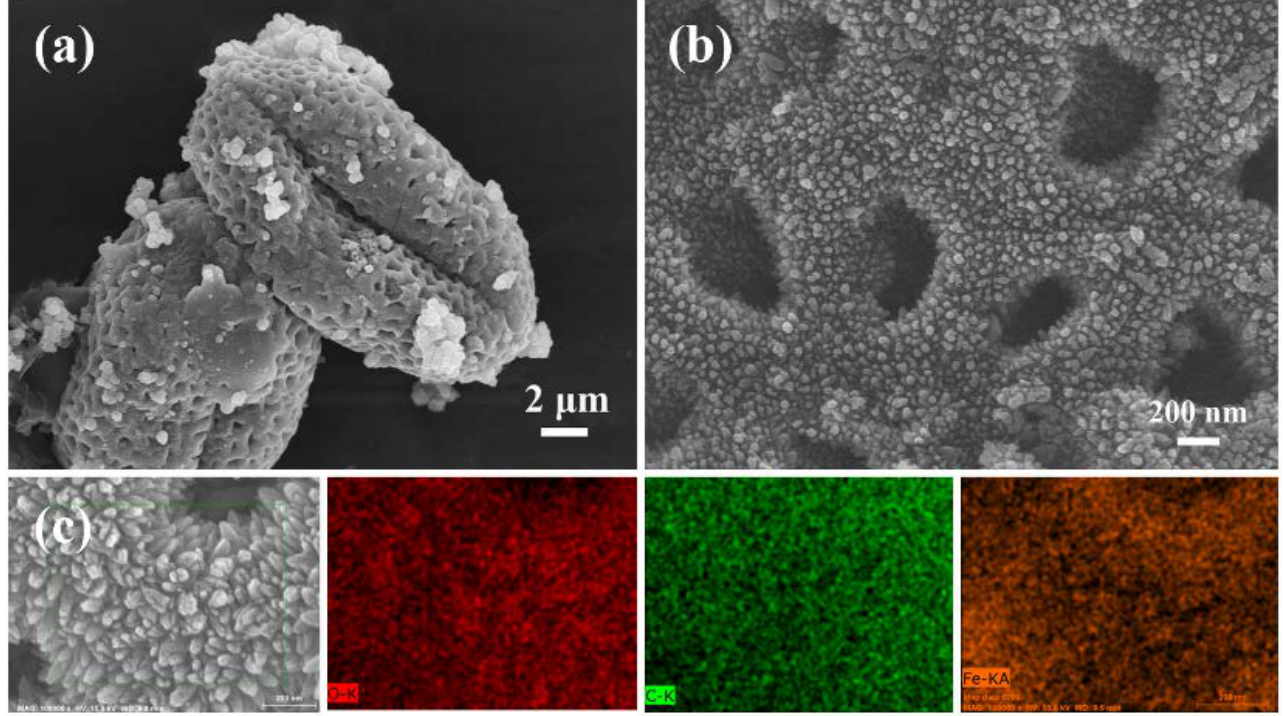
Figure 2. ( a , b ) SEM images of Fe 3 O 4 @C at low and high magnification; ( c ) EDS elemental mapping image ( c ) of Fe 3 O 4 @C.